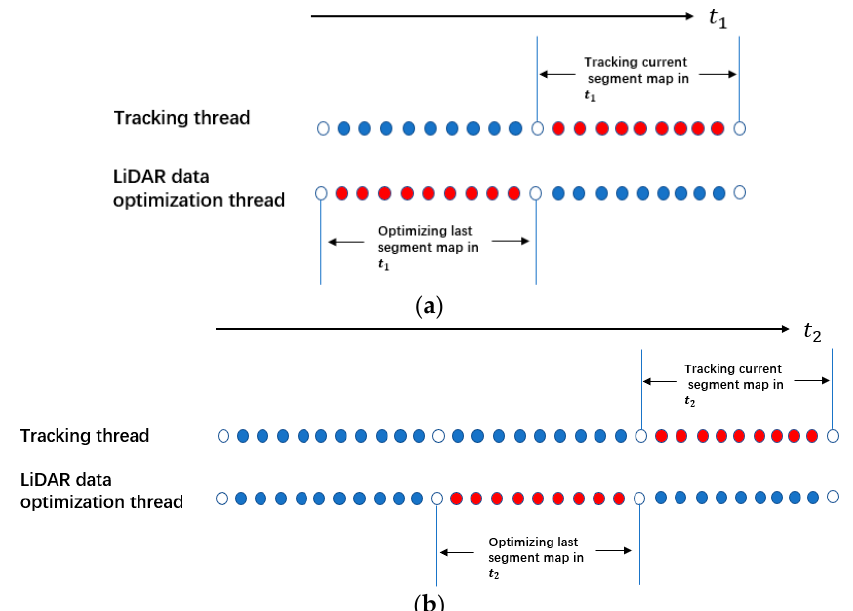
Figure 10. Tracking threads and LiDAR data optimization threads operate on different segments of the map; small dots in red represent keyframes currently activated by the corresponding thread. ( a ) keyframes currently activated by the corresponding thread in 𝑡 (cid:2869) , ( b ) keyframes currently activated by the corresponding thread in 𝑡 (cid:2870) .